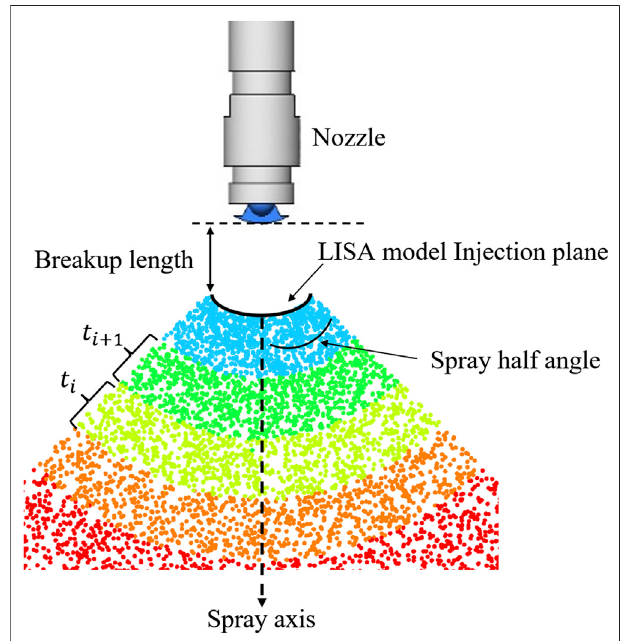
FIGURE 3 | Droplet generation method by LISA